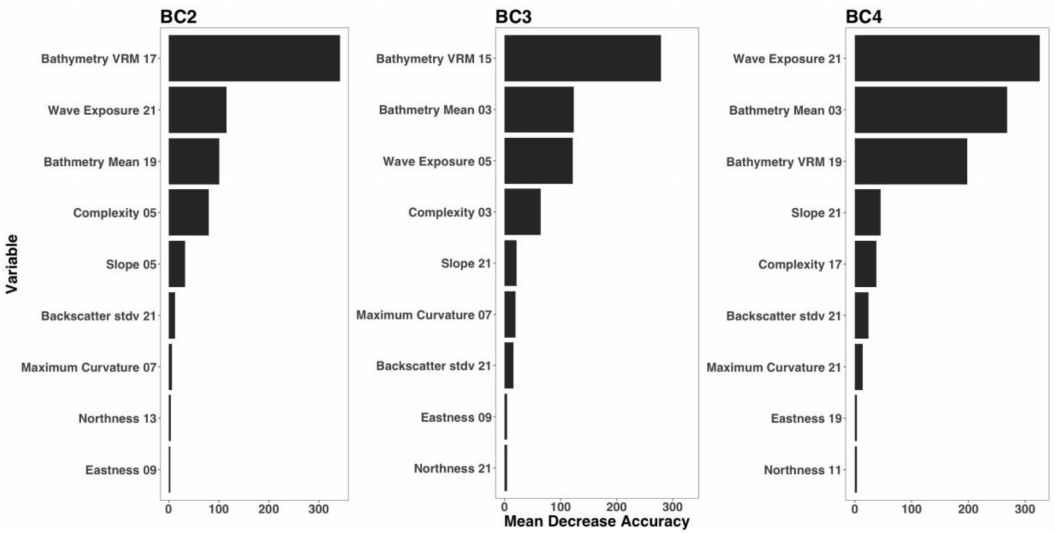
Figure 5. Variable importance for retained model variables. Mean decrease in accuracy represents the RF model decrease in accuracy when that variable is removed, therefore a larger value for mean decrease in accuracy indicates that the environmental predictor was more